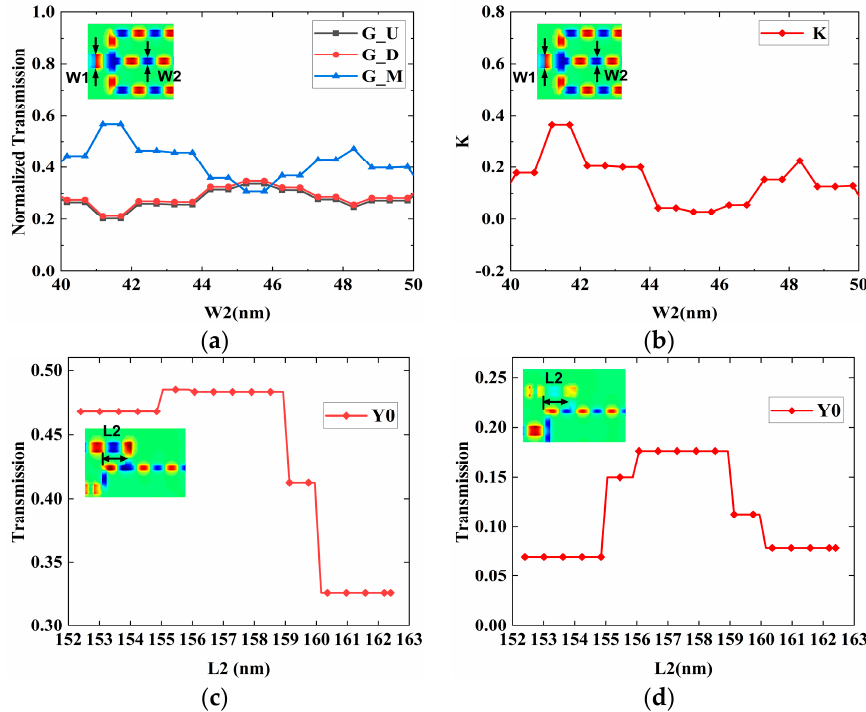
Figure 5. ( a ) Deposition of the metal layer on the dielectric substrate. ( b ) Process of patterning the selected contact electrodes to form the input electrode. ( c ) Deposition of the spacer layer on the patterned metal layer. ( d ) Transfer of graphene nanoribbons on top of the spacer layer and realiza- tion of the proposed 4×2 encoder. ( e ) Top view of the graphene waveguide. The geometric parame- ters are shown in Table 1. The dimensions are not to scale.